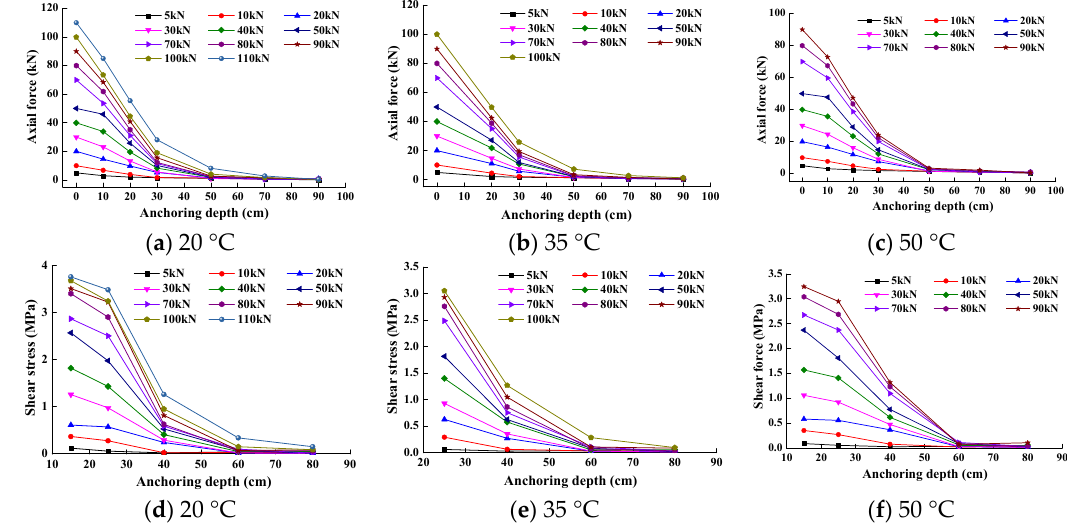
Figure 8. Axial force and shear stress distribution diagrams under different loads: ( a , d ) for Specimen D2; ( b , e ) for Specimen D3; ( c , f ) for Specimen D5.